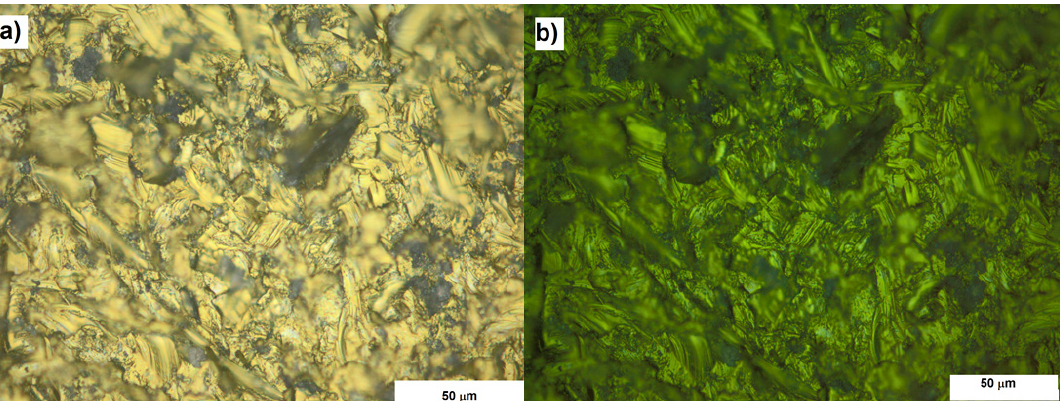
Figure 1. Microphotography of sample CP4 representative of all surfaces subjected to sandblasting. ( a ) Optical ( b ) UV fluorescence. Magnification 500× .